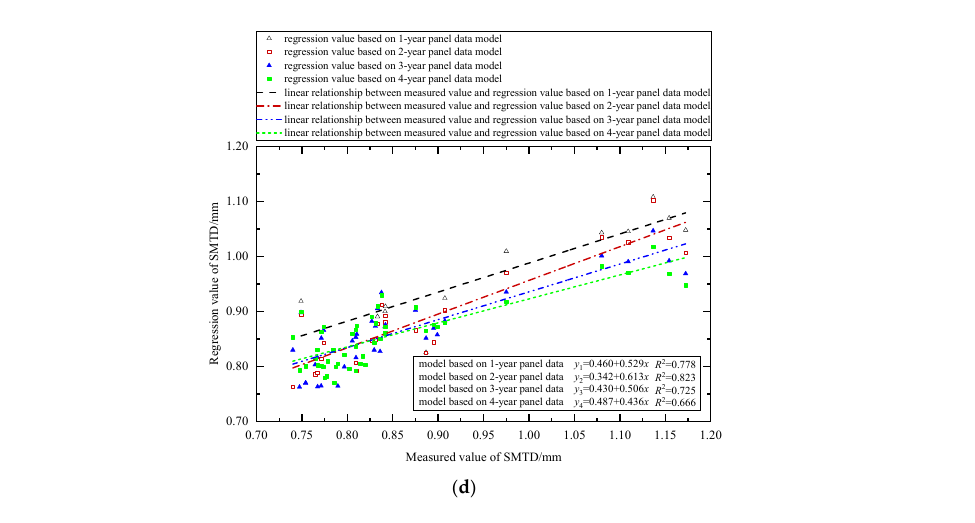
Figure 7. Linear relationship between the measured data and the regression results of the model based on different time scales of panel data. ( a ) SRT-14 (Dense-graded asphalt concrete, SAC13-65%). ( b ) SRT-7 (Dense-graded asphalt concrete, SAC13-70%). ( c ) SRT-9 (Porous asphalt concrete, PAC13-80%). ( d ) SRT-19 (Dense-graded asphalt concrete, SMA13-75%).